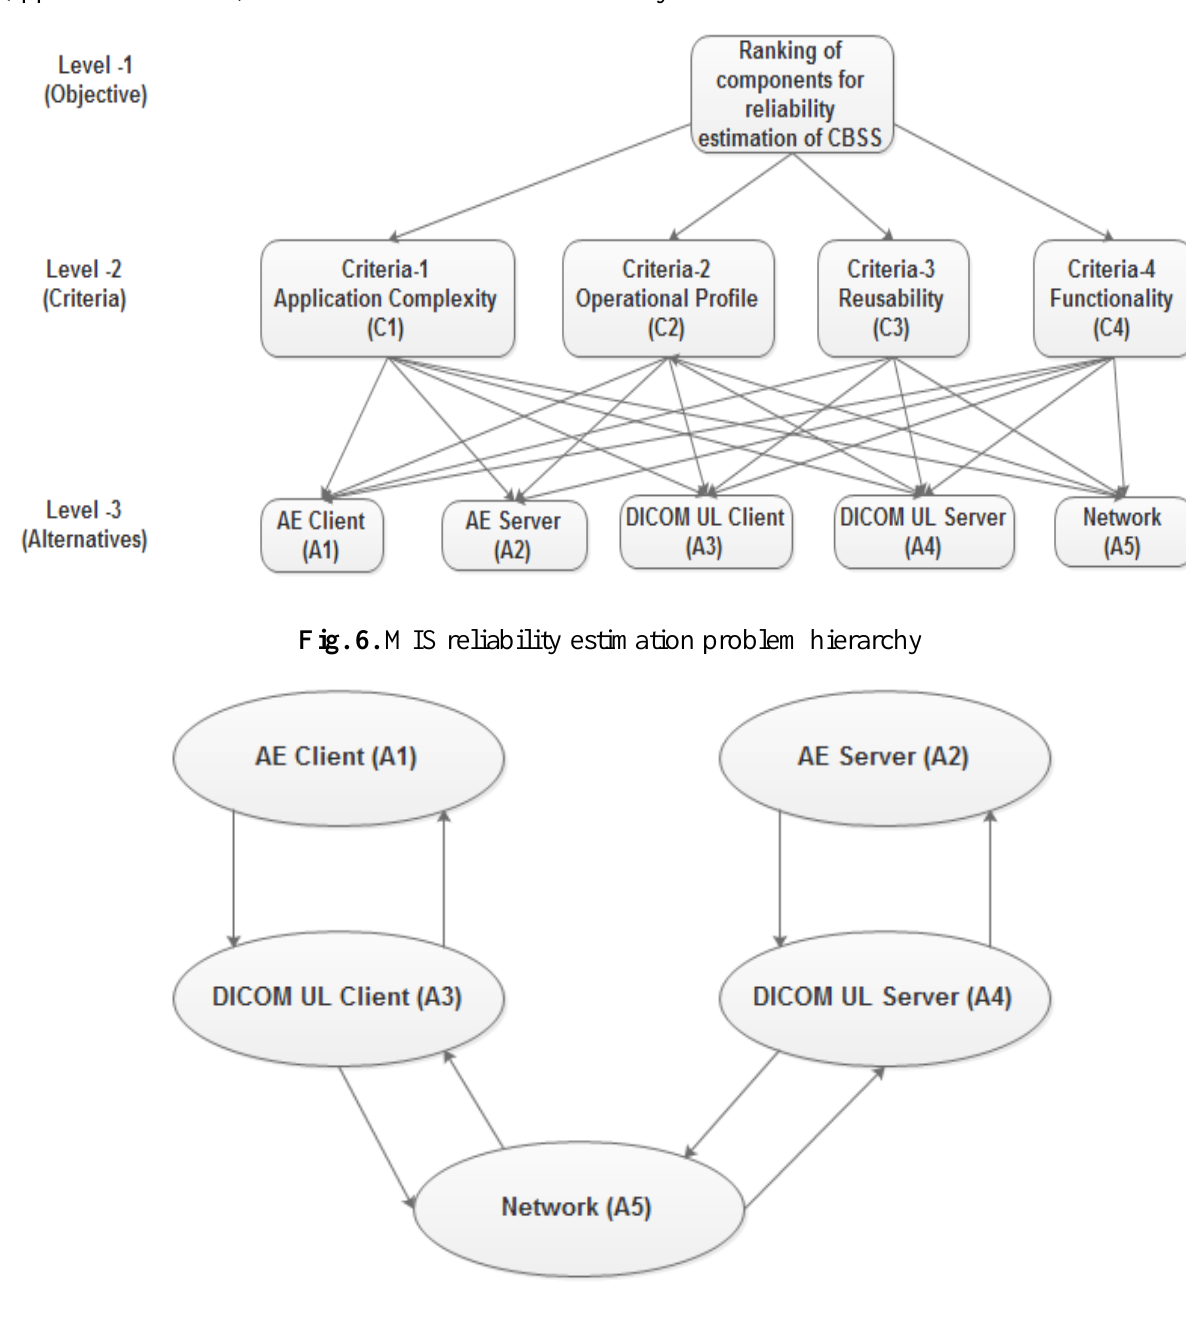
Fig. 7. Graphical representation of